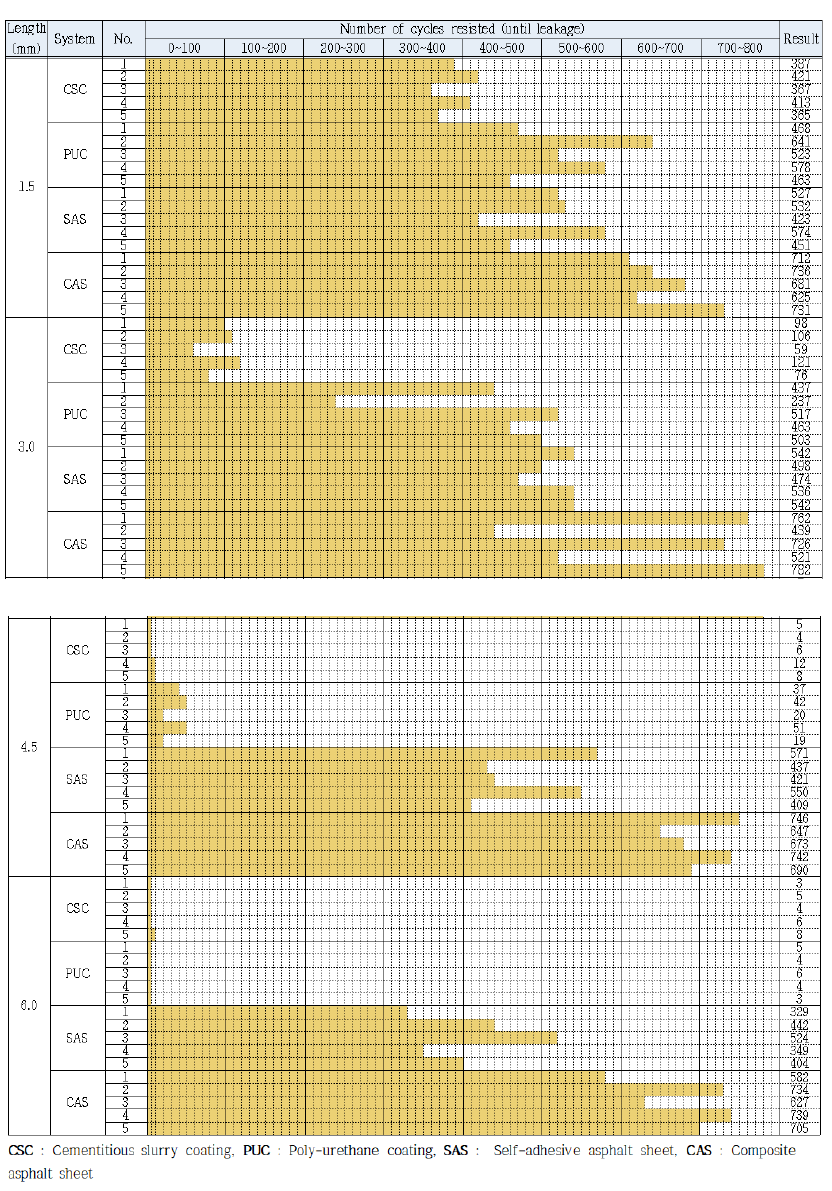
Figure 11. Joint opening resistance performance result (per opening range).